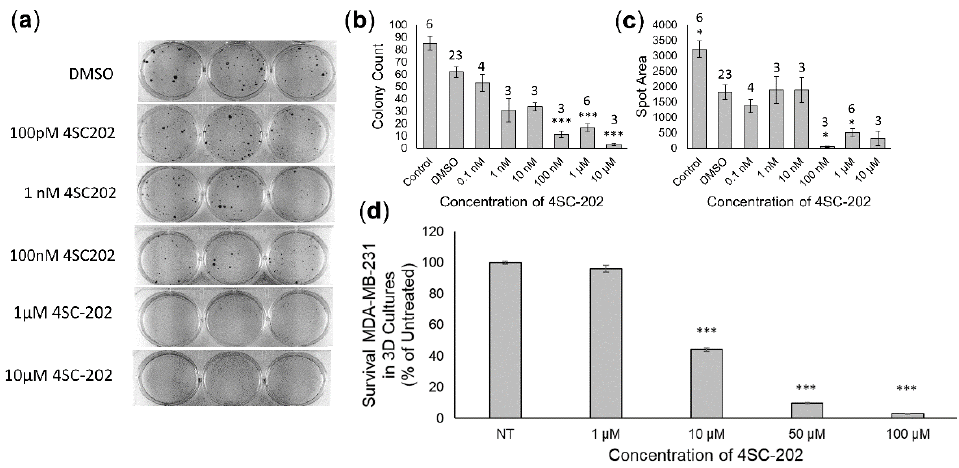
Figure 3. 4SC-202 is cytotoxic to human TNBC MDA-MB-231. ( a , b ) Concentrations of 4SC-202 ranging from 100 nM to 10 µM significantly reduced the number of colonies and ( c ) concentrations ranging from 0.1 to1 µM significantly reduced the area of colonies indicating both a cytotoxic and cytostatic effect. Number of replicates is indicated above each bar. ( d ) Using a 3D-scaffold for MD-MB-231, the survival of cells decreased significantly (10 µM, 50 µM, 100 µM) as the concentration of 4SC-202 was increased for n = 3 scaffold experiments with 3 technical replicates. Hypothesis testing was conducted using ANOVA followed by a post hoc Dunnett’s test. Significance differences are indicated relative to DMSO vehicle ( b , c ) or untreated (NT) ( d ) groups (adj p < 0.05 *, adj p < 0.001 ***). Error bars are the standard error of the mean (SEM).